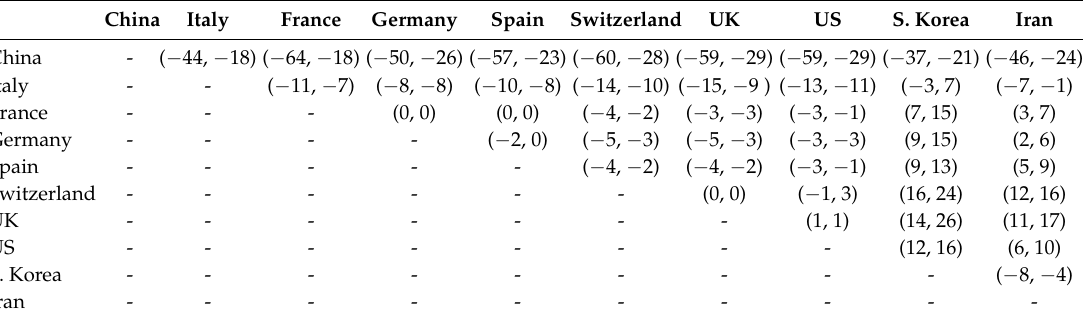
Table 1. Pair-wise confidence intervals of the estimated lags between the countries. Negative values indicate that the first country (row) leads the second country (column) and vice